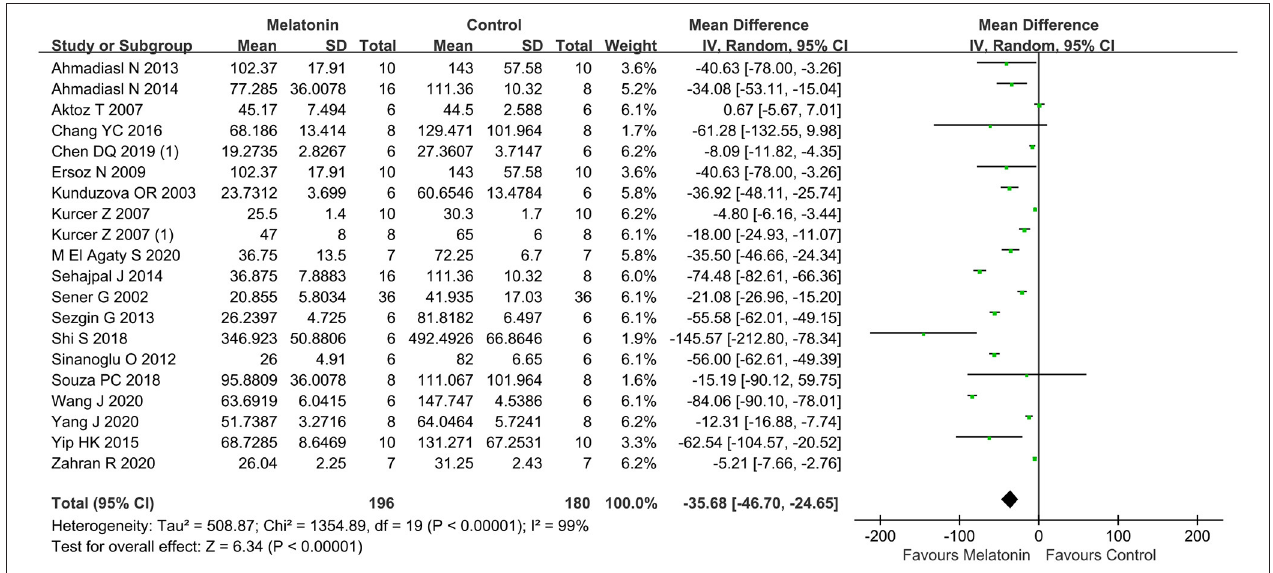
FIGURE 2 | Forest plot for the effects of melatonin on blood urea nitrogen.